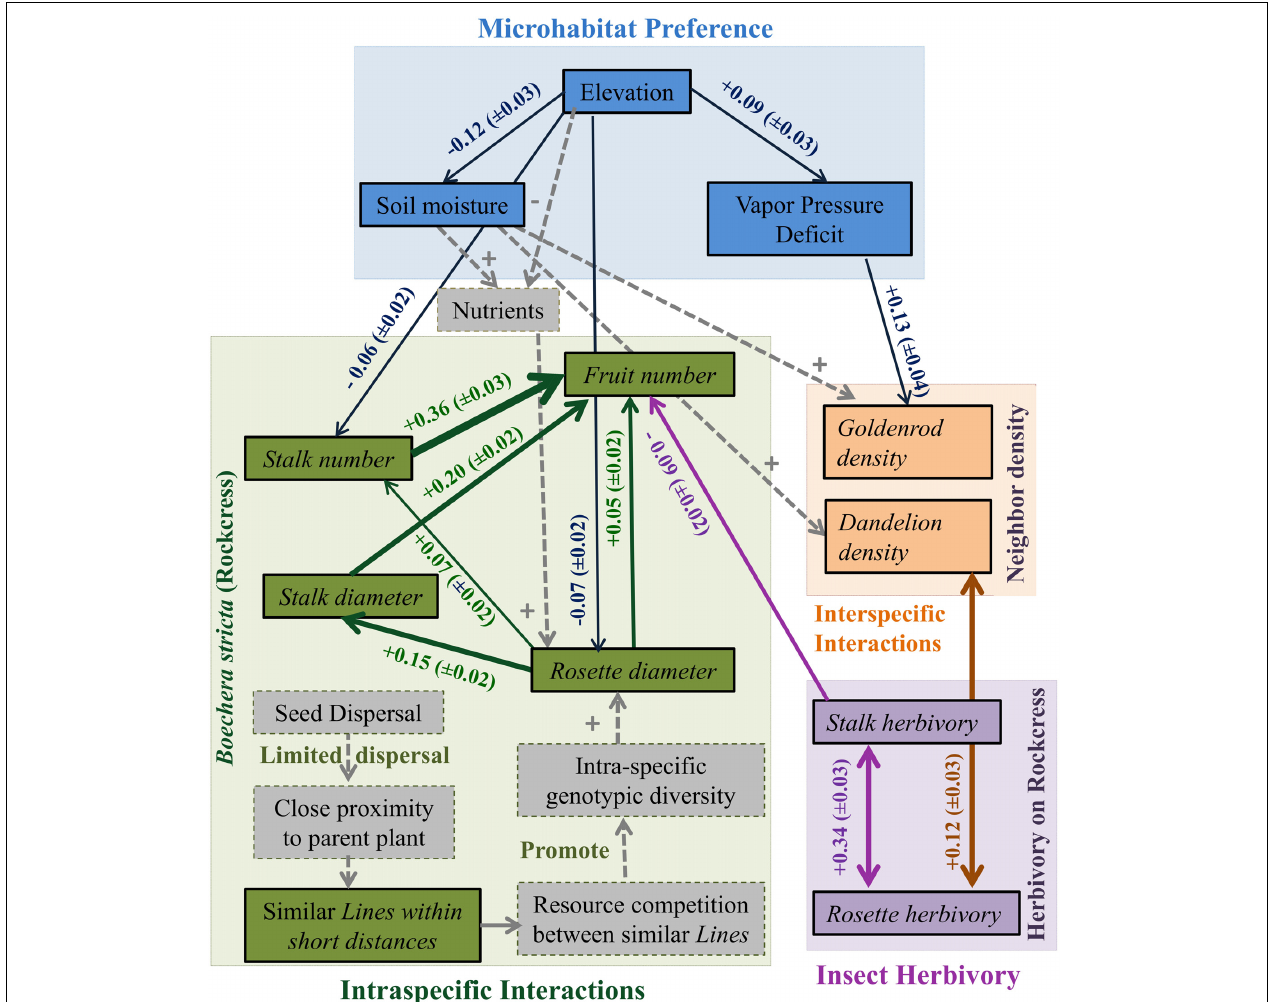
FIGURE 4 | An ecological network of interactions between abiotic environmental factors (Elevation, Vapor pressure deficit, Soil moisture, and Nutrients), intra-specific performance and fitness measures ( rosette diameter , stalk diameter , fruit number , stalk number , and line ), and inter-specific neighbors and herbivory ( goldenrod density , dandelion density , rosette herbivory , and stalk herbivory ) in a rockcress population. Boxes represent observed variables and arrows represent significant partial correlations. Sign